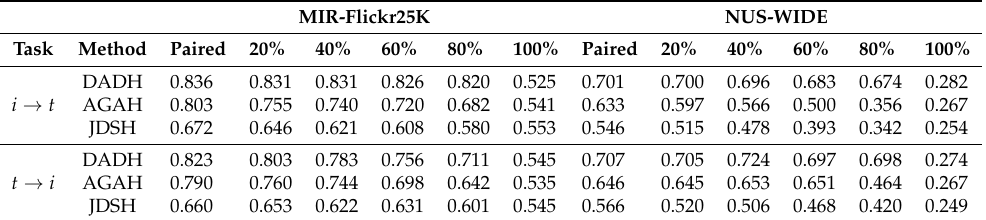
Table 4. Results (mAP) on MIR-Flickr25K and NUS-WIDE with unpaired text, i.e., text with no corresponding images. Column ‘Paired’ shows results when training with a fully paired training set. Subsequent columns show results with increasing amounts of unpaired text in the training